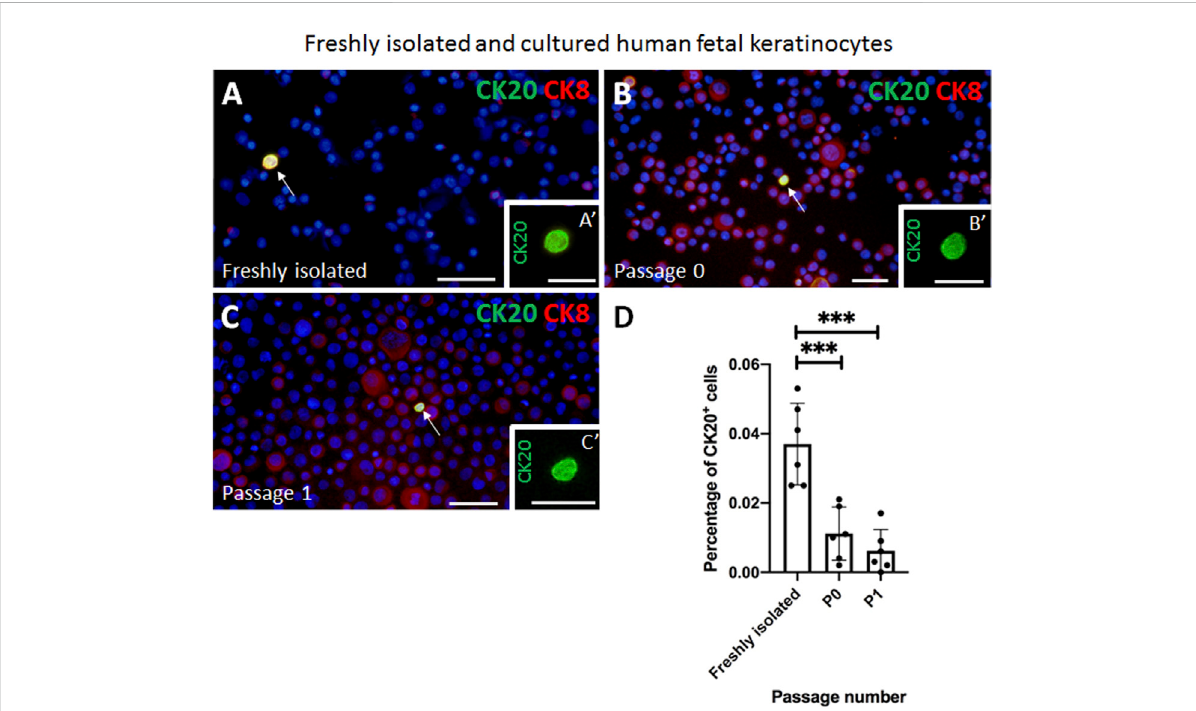
FIGURE 2 Examples of immuno fl uorescence staining of freshly isolated and cultured cytospinned keratinocytes from human fetal skin. (A,A 9 ) CK20 (green) and CK8 (red) double positive Merkel cell is present in freshly isolated keratinocytes. (A 9 ) shows a magni fi cation of the CK20-positive (green) Merkel cell shown in (A) . (B,B 9 ) CK20-positive (green) Merkel cell is present in cultured cells (Passage 0). Note the expression pattern of CK8 (red) in non-Merkelcells. B 9 indicatestheCK20-positive(green)Merkelcelldisplayedin (B) . (C,C 9 ) ExpressionofCK20(green)inculturedcells(passage 1 in C , C 9 ). CK8 (red) is also expressed in non CK20-positive Merkel cells. (C 9 ) displays the CK20-positive (green) Merkel cell in (C) . (D) The fraction of CK20-positive Merkel cells decreases during in vitro culturing. Statistical analysis shows a steady decrease of CK20-positive Merkel cells from 0.037% ± 0.012% freshly isolated cells to 0.011% ± 0.007% (Passage 0, P0) and to 0.006% ± 0.006% (Passage 1, P1). The decrease is most signi fi cant between freshly isolated cells and Passage 0( p < 0.001) and betweenfreshly isolated cells and Passage 1 ( p < 0.001). Ordinary one-way ANOVA